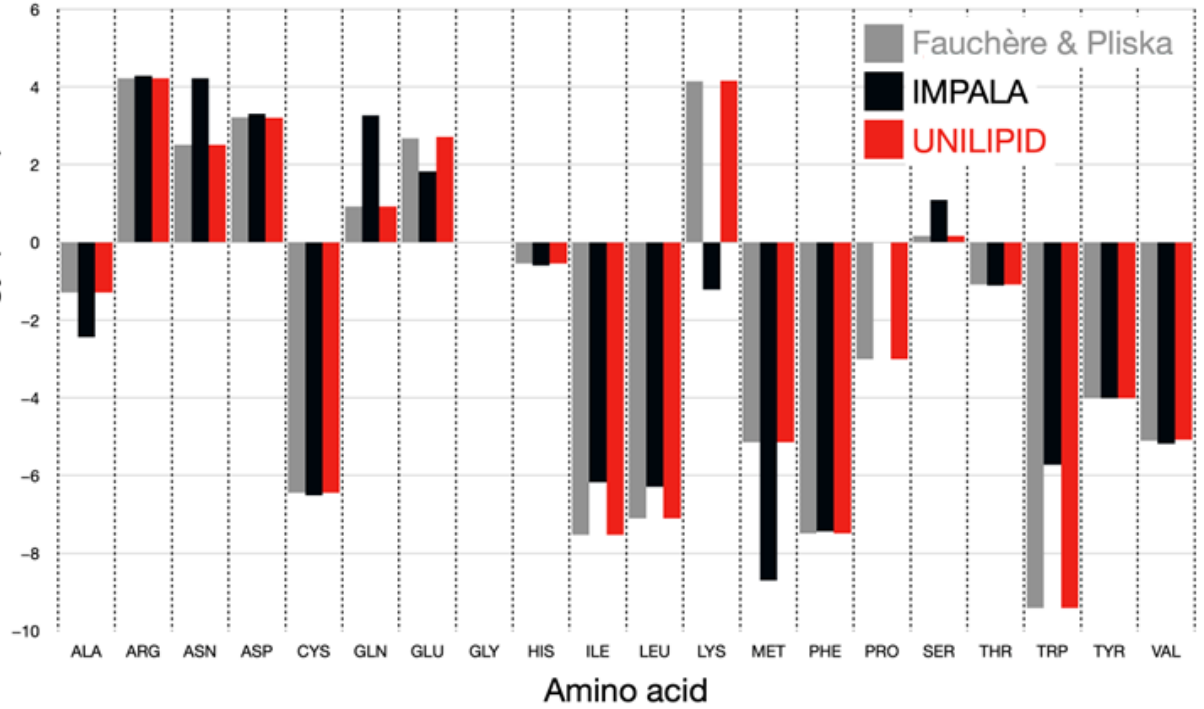
Figure 7. Bar graph of the transfer energy for the movement of each amino acid side chain into a membrane environment. The experimental reference scale is shown in gray, the calculated energies using the original IMPALA parameters in black, and the new UNILIPID parameterization in